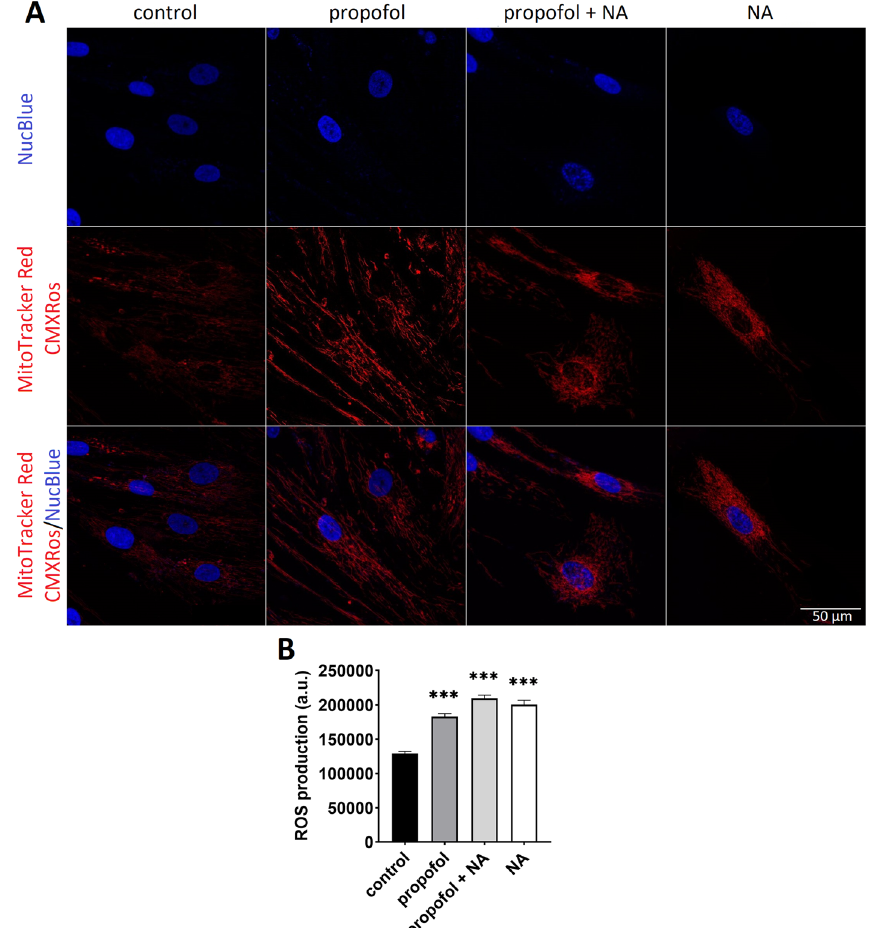
Fig. 5 ROS production. A Representative confocal images from myoblasts stained with MitoTracker Red CM-H2XRos to detect accumulation of mitochondrial specific-reactive oxygen species. Experiments were performed on at least 90 cells per group from n 3 independent experiments (with cells from 3 individual = subjects). B Determination of ROS production in different groups. Error bars indicate standard error of the mean. *** p < 0.001 vs. control group. NA